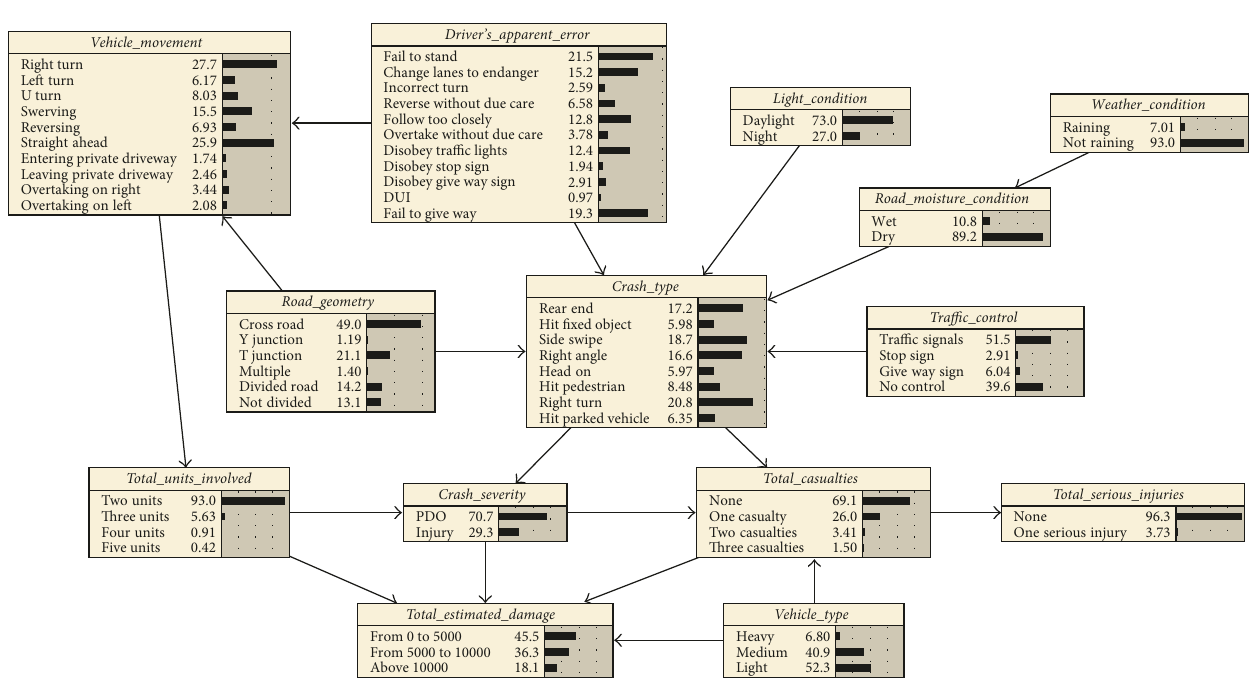
Figure 4: The Bayesian network model after parameter learning in Netica